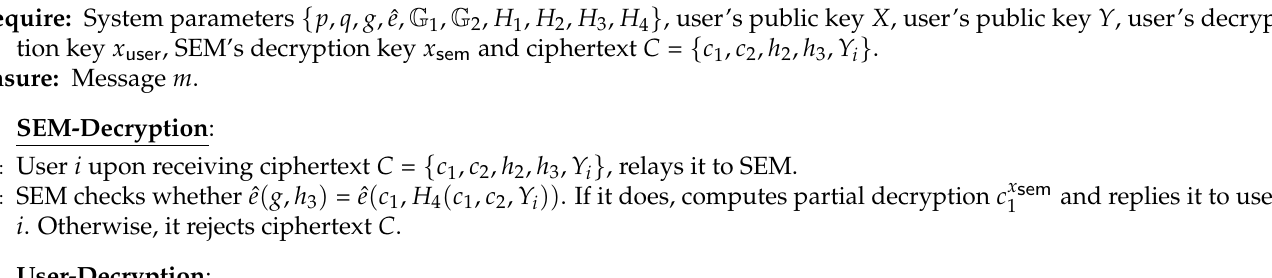
Algorithm 3 Decryption ( D ECRYPT ) of